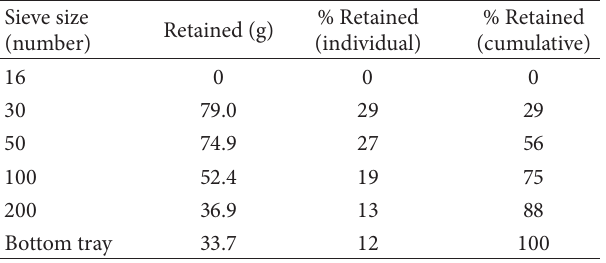
Table 1: Sieve analysis of silica sand (Fineness modulus = 1.59 ).